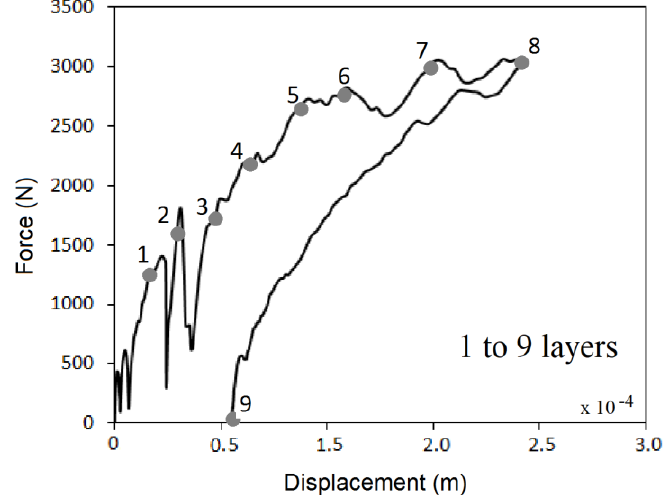
Figure 15. Comparison of the force vs. displacement diagram for an impact at 50 J in unmodified panel.